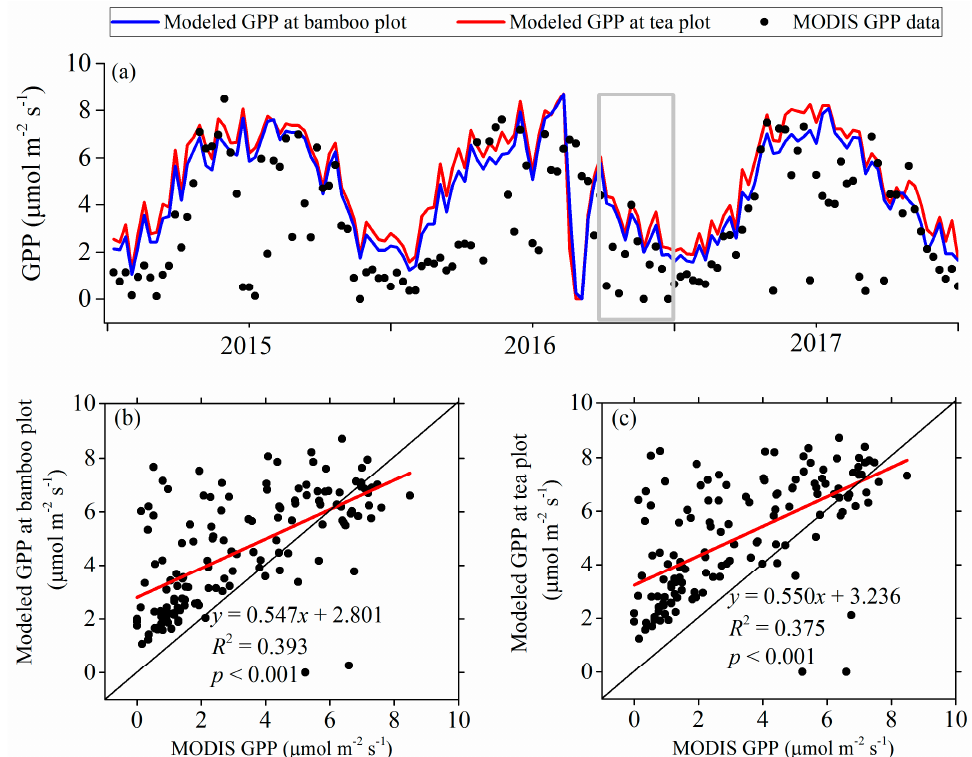
Figure 6 . MODIS and the modeled 8-day Gross Primary Production (GPP) at the study site. The